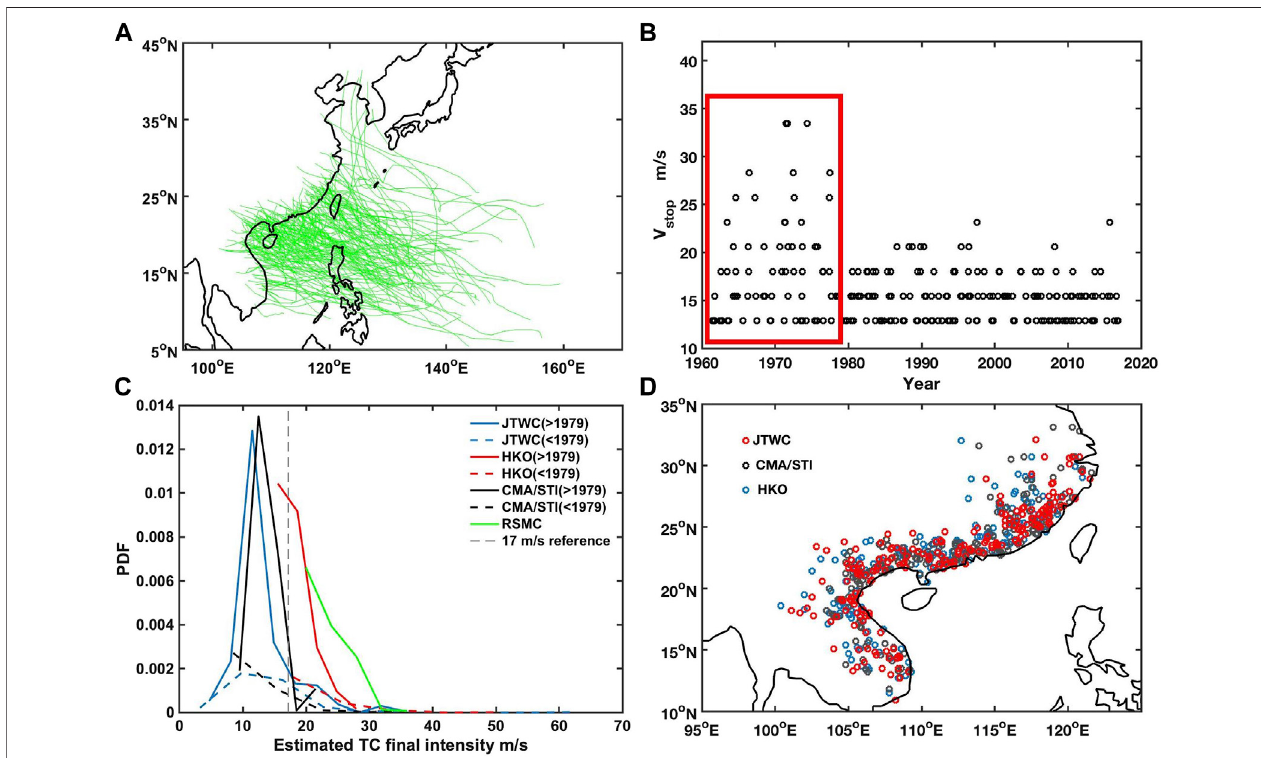
FIGURE 2 | (A) Tracks of the selected WNP TCs from 1979 to 2016 in the JTWC best track dataset. (B) TCs ’ fi nal intensity issued by the HKO. Circles in the red rectanglearetheTCs ’ terminalintensitiesannouncedbefore1978. (C) ChangesofPDFsoftheTC fi nalintensityissuedbyJTWC,HKO,CMA/STI,andRSMCbeforeand after 1979. (D) Comparisons of Terminal locations typhoons can reach when maintaining maximum wind speed of 17 m/s across different best track datasets.